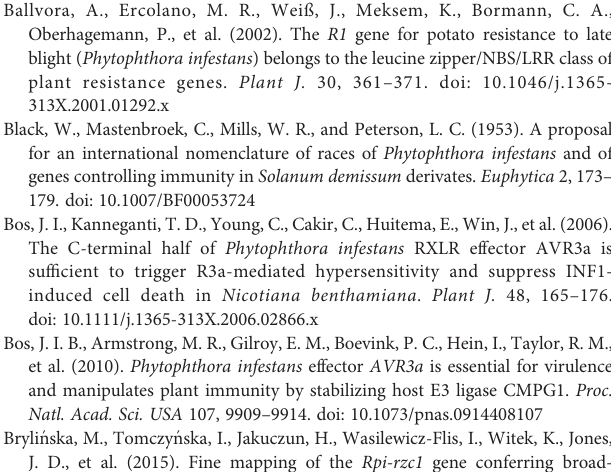
SUPPLEMENTARY TABLE S3 | List of speci fi c primers used for detection of R8 and Rpi-vnt1 by PCR ampli fi cation. SUPPLEMENTARY TABLE S4 | Segregation for PiAvr3a EM response in the F1 populations of crosses Longshu7 X CIP01, Longshu7 X CIP16, and Qingshu9 X ND. SUPPLEMENTARY FIGURE S1 | Effect of various growth ages of potato seedlings on the ef fi ciency of Agrobacterium tumefaciens -mediated transient expression. Leaves of three different growth stages, 3-4, 6-7 and 9-10 week-old seedlings, were investigated. Five P. infestans Avr genes PiAvr1, PiAvr2, PiAvr3a KI , PiAvr4 and PiAvr8 were expressed by A. tumefaciens AGL1, OD 600 of 0.4, in fi ve potato differential genotypes carrying cognate R genes R1 , R2 , R3a , R4 and R8 , respectively. Co-in fi ltration of PiAvrblb1 and RB was used as a positive control, whereas GFP used as a negative control. The number of HR sites/total number of in fi ltration sites were indicated in each treatment. All photographs were taken 5 dpi. SUPPLEMENTARY FIGURE S2 | Infection of Qingshu9 and Longshu7 to different P. infestans strains. Detached lea fl ets of 9-10 week-old plants were drop- inoculated with 4×10 4 sporangia/mL of six P. infestans strains with known virulence spectrum, including PjY009, PjY048, PjY061 (Yunnan, Southwestern China), Pa21106, Pd21410 (Ningxia, Northwestern China) and F48 (Fujian, Southeastern China), with sterilized dH 2 O as the control treatment. Qingshu9 was highly resistant (R) to Pa21106, Pd21410 and F48, but susceptible (S) to PjY009, PjY048 and PjY061. Longshu7 was resistant to PjY061, Pa21106, Pd21410 and F48, but susceptible to PjY009 and PjY048. Disease index (DI) were scored and photographs were taken 5 dpi. The experiment was repeated four timed with fi ve replicates. SUPPLEMENTARY FIGURE S3 | Detection of R8 and Rpi-vnt1 in Qingshu9 and Longshu7 by PCR ampli fi cation using gene-speci fi c primers. Two sets of gene- speci fi c primers for R8 and Rpi-vnt1 each were used for their